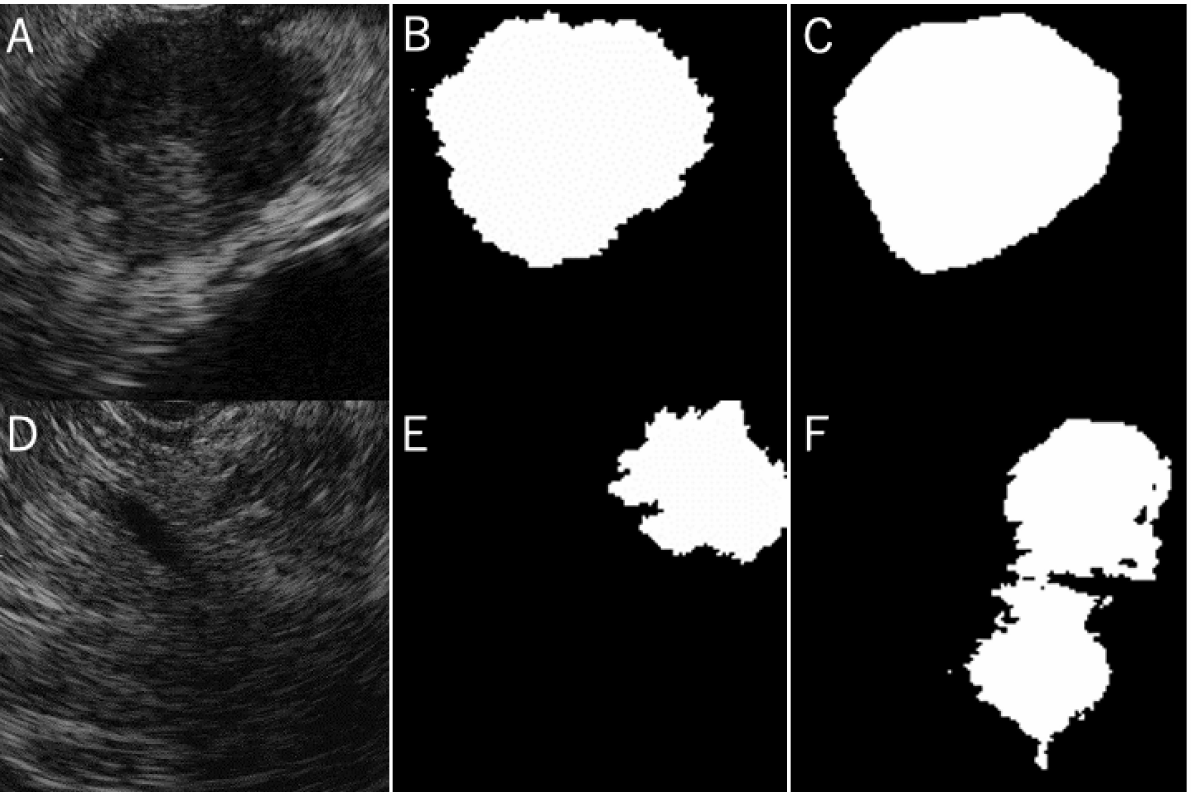
Figure 5. Cases of the highest and lowest concordance. Images of tumor in B-mode of highest intersection over unit (IoU) case ( A ). The manually labeled area ( B ) was almost the same as the automatic segmented area ( C ). Images of tumor in B-mode of lowest IoU case ( D ). The manually labeled area ( E ) was not similar to the automatic segmented area ( F ).